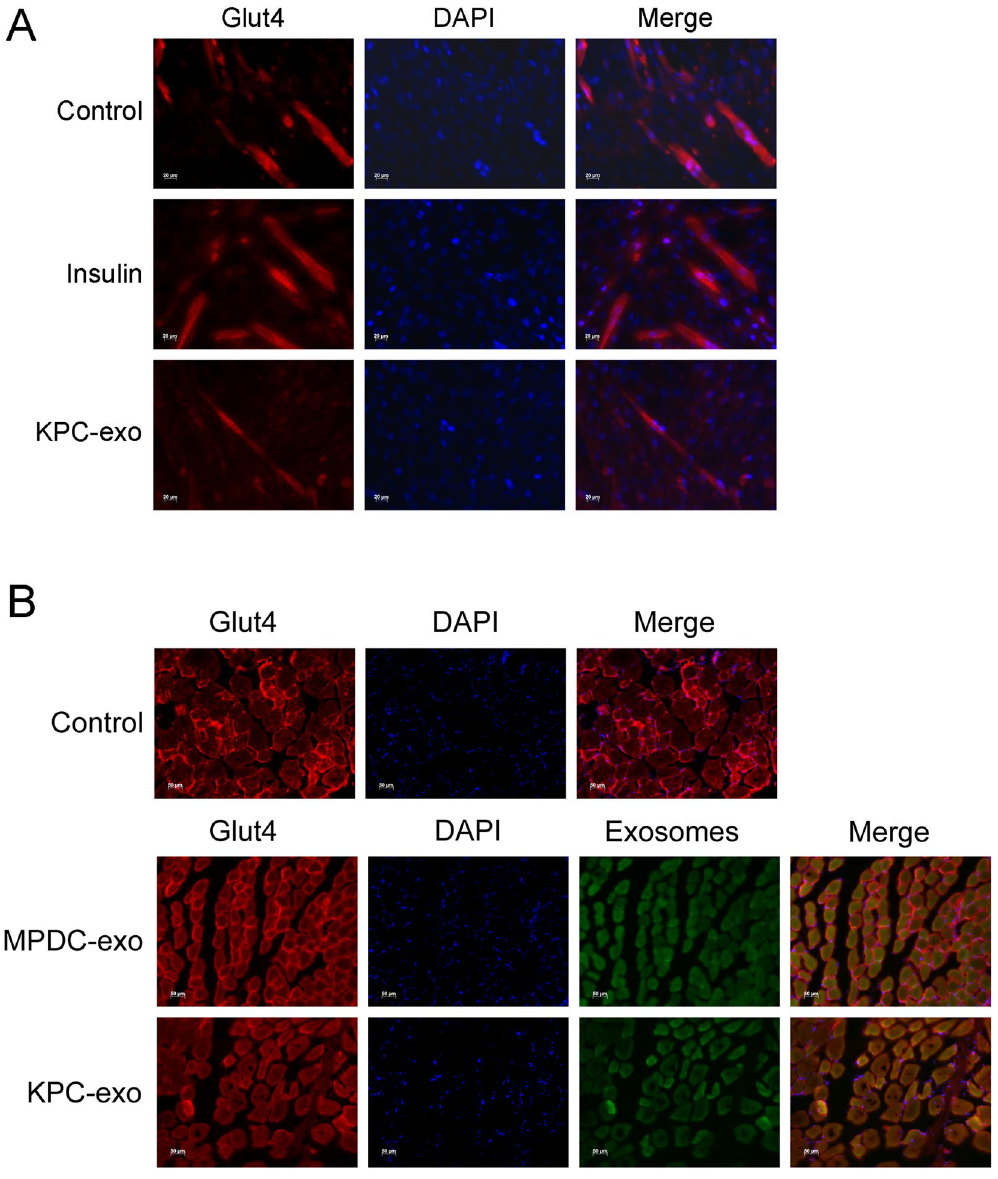
Figure 5. KPC-exosomes inhibit Glut4 translocation to the plasma membrane. ( A ) Differentiated C2C12 cells cultured in 24-well plates were treated with 1 μ g/ml KPC-exosomes per well for 24 h or 10 − 7 M insulin for 30 min. The membrane distribution of Glut4 (red) was verified by immunofluorescence. Scale bar, 20 μ m. ( B ) 20 μ g PKH67-dyed (green) exosomes in 100 μ L PBS was injected through the caudal vein into each mouse. The membrane distribution of Glut4 (red) was verified by immunofluorescence. Scale bar, 50 μ